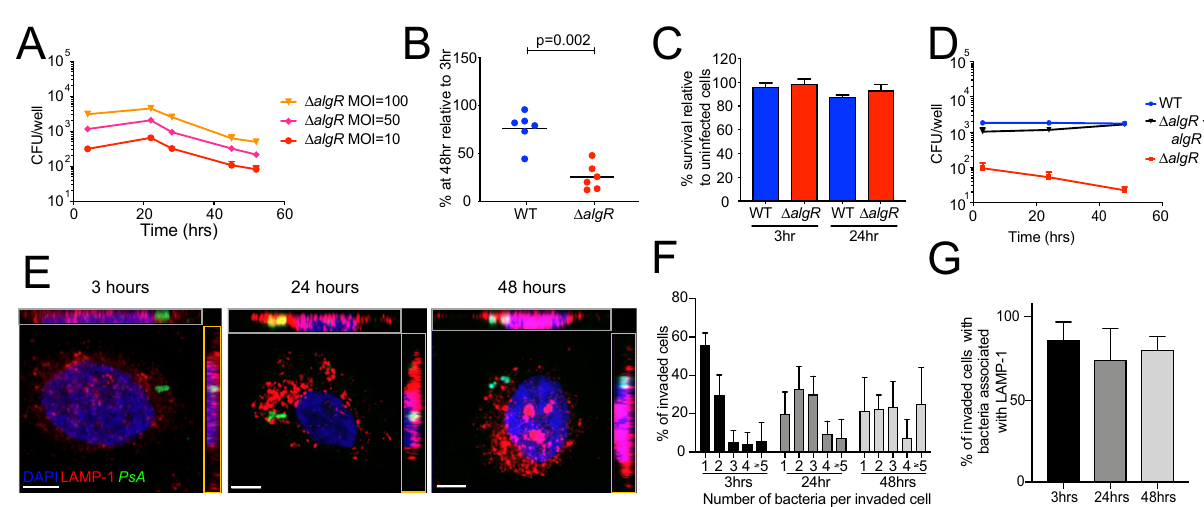
Fig 2. The bacterial two-component response regulator AlgR is required for intracellular survival of Pseudomonas aeruginosa . (A) Cells were infected with increasing MOIs of Δ algR bacteria and intracellular bacterial load was determined. (B) Percent of recovered bacteria at 48 hpi relative to 3 hpi with MOI = 10. Each data point represents an independent experiment. Data were analyzed by unpaired T-test. (C) Host cell survival was measured at 3 and 24 hpi with WT or Δ algR bacteria at MOI = 10 relative to uninfected cells harvested at the same time point. (D) algR was complemented in the Δ algR deletion strain and cells were infected and harvested as in A. (E-F) Cells were infected with Δ algR GFP-expressing bacteria at MOI = 10, fixed at the indicated time points and stained with anti-LAMP-1 antibodies and DAPI. (E) Representative images of invaded cells. Maximum intensity projections of XY (middle), and orthogonal XZ (gray outline) and YZ (orange outline) projections of the serial confocal images are shown. Scale bar = 5 μ m. (F) Intracellular bacterial load as determined by microscopy. (G) Percent of invaded cells with LAMP-1-associated bacteria. Data is representative of 4–6 biological replicates with at least 50 cells per condition. Error bars represent standard deviation.